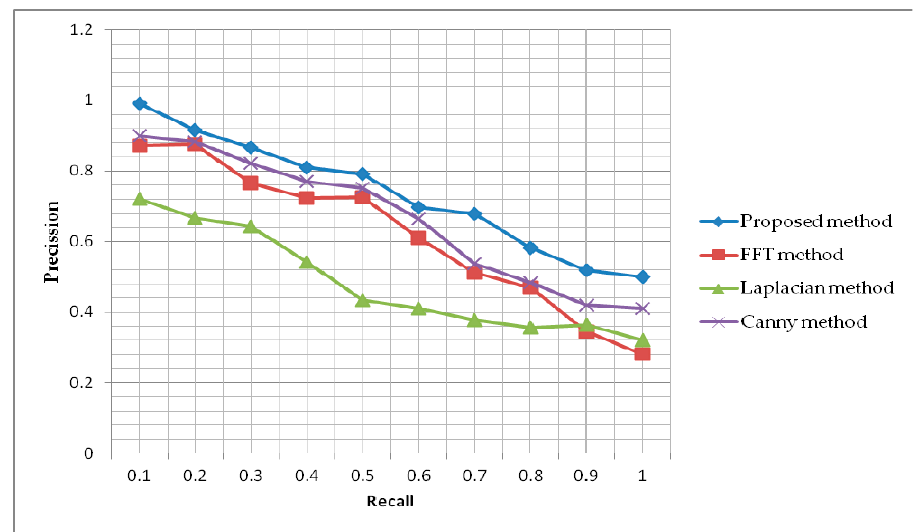
Figure 8. Quantitative Precission-Recall curve of different blur detection approaches.